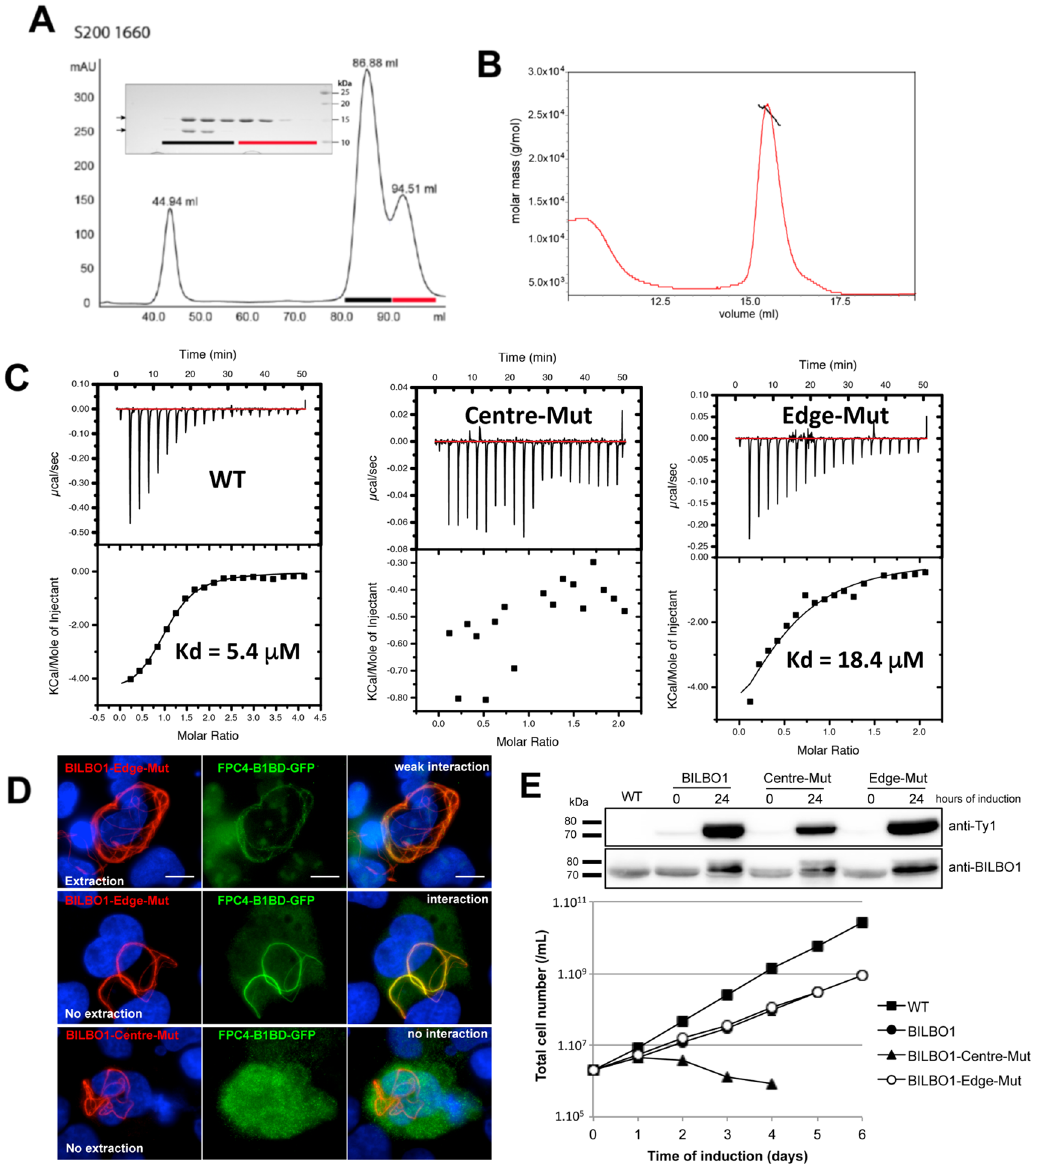
Fig 2. The formation of a stable complex between the BILBO1-NTD and FPC4-B1BD depends on the residues Y87 and F89 on the BILBO1-NTD. (A) SEC elution profile (S-200 16/60) of the mixture of purifiedBILBO1-NTD’ (aa1- 120) and FPC4-B1BD (aa357-440). Both proteinswere co-eluted in the elution peak of 86.88 ml. The 44.95 peak is the void volume. Inset: Coomassie-stained SDS-PAGE gel showingproteins in the fractions indicatedwith the coloured bars in the elution profile. Upper arrow indicatesthe BILBO1-NTD’ and lower arrow indicates FPC4-B1BD. (B) SLS results of the complexof BILBO1-NTD’ and FPC4-B1BD. The apparentmolecularmass of 24.9 kDa indicatesthe formation of a hetero-dimer. (C) ITC analysisshowingthat interaction with FPC4-B1BD is partially reducedin BILBO1-Edge-Mut but completelyabolished in BILBO1-Centre-Mut. (D) Co-expression in U-2 OS cells and immunolabellingon permeabilisedcells (no extraction)or extracted cells (extraction) of FPC4-B1BD-GFP (anti-GFP, green) with either BILBO1-Centre-Mut or BILBO1-Edge-Mut (anti-BILBO1, red). Nuclei were DAPI stained. Scale bar represents 10 μ m. The experiments were performed more than three independenttimes. (E) WB and growth curves for the PCF WT and inducedcell lines for the expressionof Ty1-tagged BILBO1, BILBO1-Centre-Mut, and BILBO1-Edge- Mut. Error bars represent the standarderror from 3 independentexperiments (and are smaller than the data point mark).